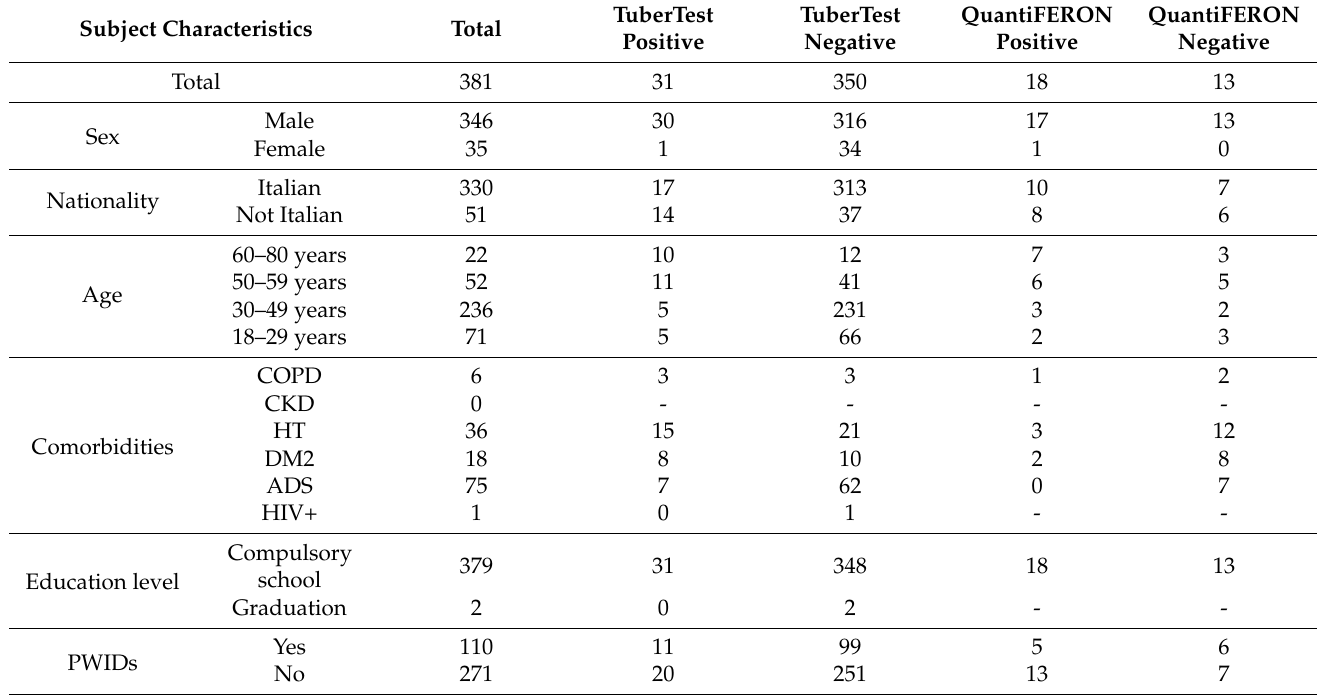
Table 2. Frequency of each variable among our cases considering the results of the TuberTest and QuantiFERON. ADS indicates anxious-depressive syndrome; COPD, chronic obstructive pulmonary disease; CKD, chronic kidney disease; DM2, type 2 diabetes mellitus; HIV, human immunodeficiency virus; HT, hypertension; PWIDs, people who inject drugs.